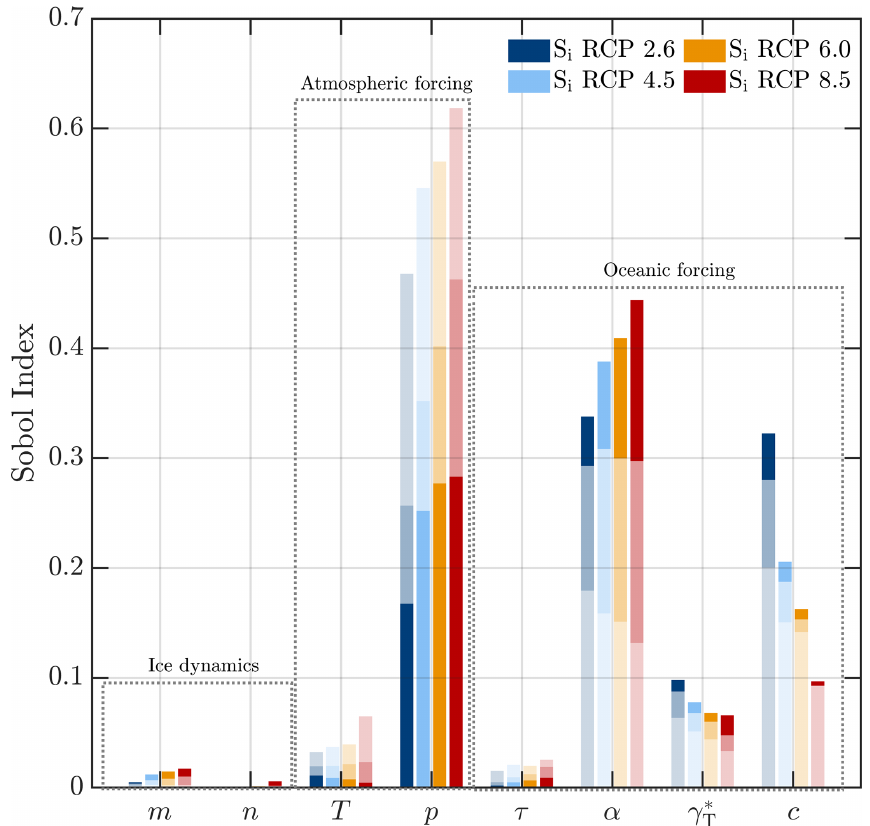
Figure 7. First-order Sobol indices, i.e. the fractional contribution of each input parameter on the uncertainty in our projections of (cid:49) GMSL, for each RCP forcing scenario. Dark shading shows the Sobol indices for (cid:49) GMSL in 2300. Two lighter shading colours represent Sobol indices at the years 2100 and 2200, to show the variability in parameter importance through